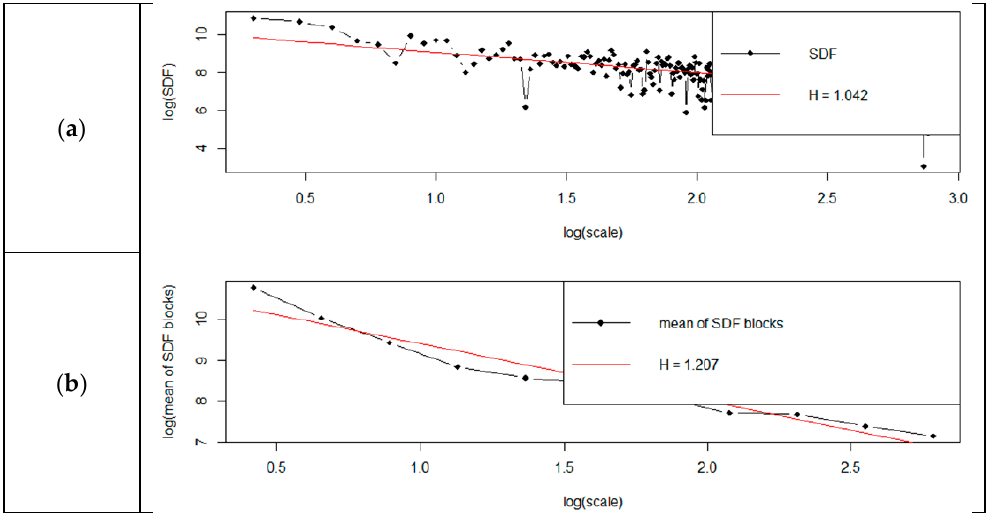
Figure 5. Spectral regression graph by the direct method: ( a ) the standard method, ( b ) the smoothed method.